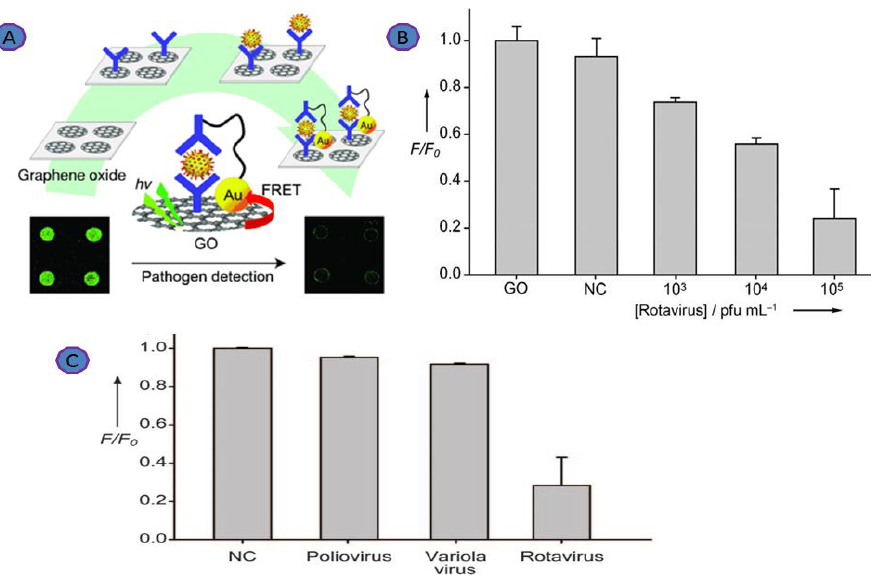
Figure 3. ( A ) Illustration of the GO-based immuno-biosensor; ( B ) dynamic range of the GO-based sensor; ( C ) cross-reactivity of the GO-based immunosensor was tested with Poliovirus and Variola virus. Reprinted with permission from Ref. [65]. Copyright 2010, Wiley-VCH.